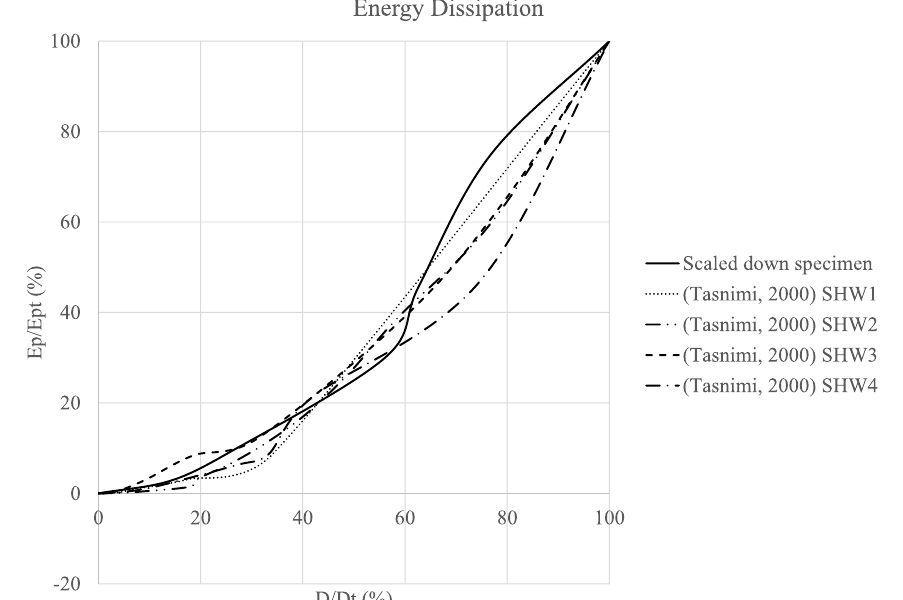
Fig. 16 Cumulative energy dissipation comparison